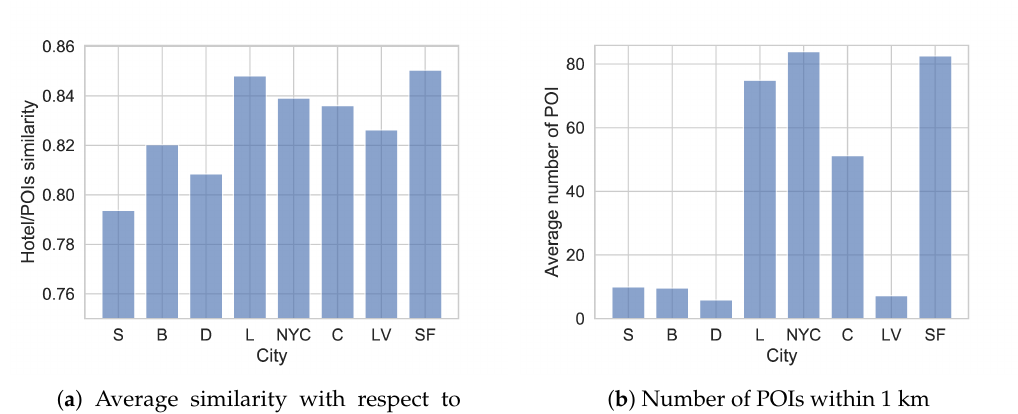
Figure 4. Average distances analysis.